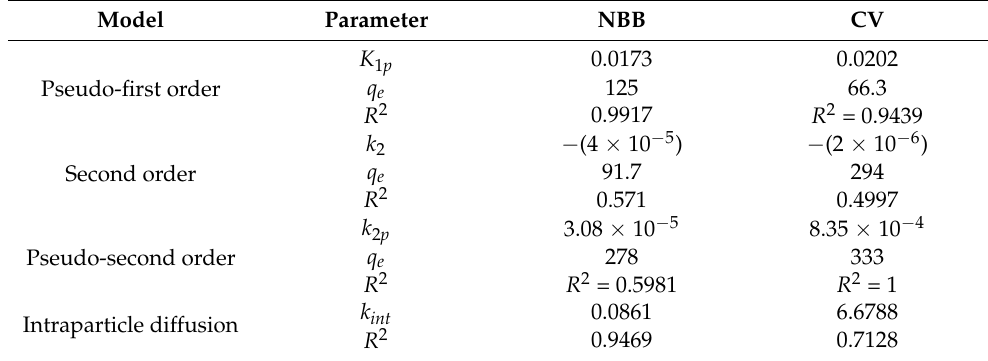
Table 3. Kinetics models parameters for the adsorption of NBB and CV dyes on ACOC.